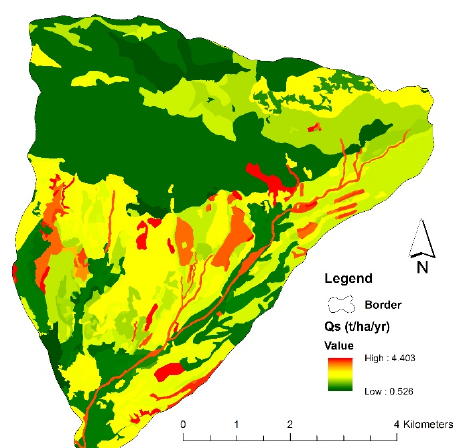
Fig. 2: (a) Isohyetal map overlaid on runoff coefficient map; (b) Runoff height extracted using the rational approach